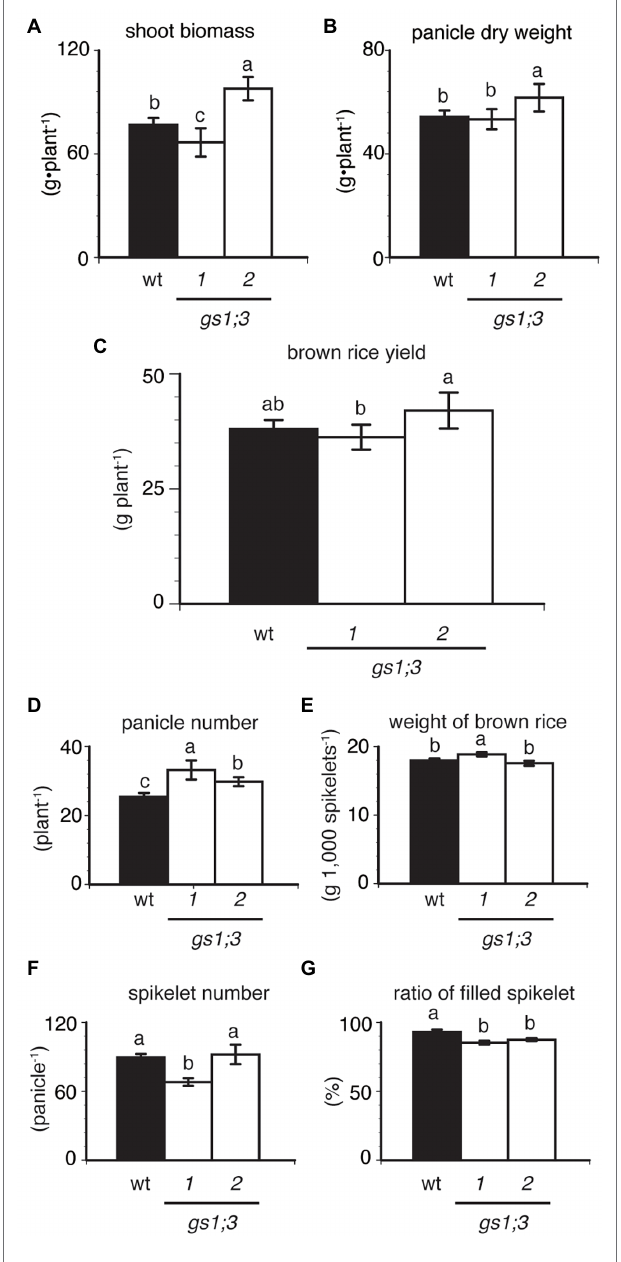
FIGURE 5 | Productivity of GS1;3 mutants grown in the paddy field. (A) Shoot biomass, (B) panicle dry weight, (C) brown rice yield (yield of dehusked, filled spikelets), (D) total panicle number, (E) weight of brown rice, (F) spikelet number per panicle, and (G) the ratio of filled spikelets of Nipponbare (WT; closed column) and GS1;3 mutant (opened columns) plants harvested after 174 days at full maturity are shown. Data represent mean ± SD ( n = 5). Significant differences within each group were determined using one- way analysis of variance (ANOVA) followed by Bonferroni tests and are indicated with different letters ( p <